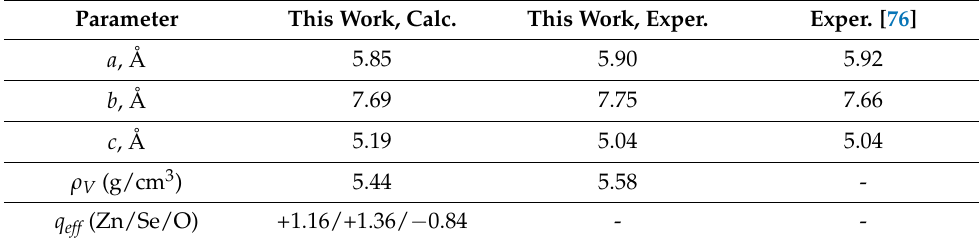
Figure 7. Atomic structure of ZnSeO 3 unit cell (56 atoms). The boundaries of the cell and the directions of the translation vectors are shown. Table 4. Calculated parameters of ZnSeO 3 crystal.